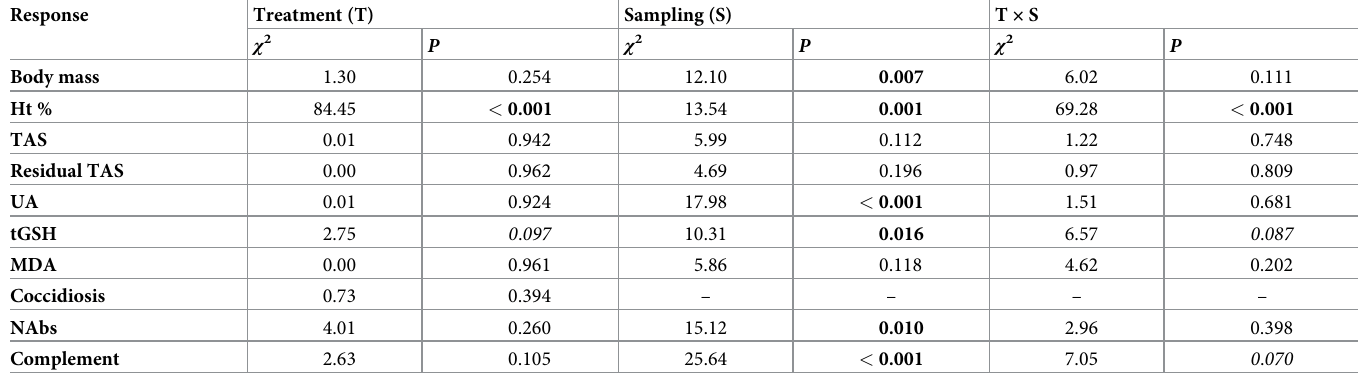
Table 1. Physiological effects of chronic CORT treatment. LMEs for body mass, hematocrit (Ht %), redox state markers (TAS—total antioxidant status, UA—uric acid, tGSH—total glutathione, MDA—malondialdehyde; for residual TAS, see Methods) and coccidian infestation, and GLMMs for innate immunity variables (natural antibod- ies [NAbs] by hemagglutination score and complement by hemolysis scores). Degrees of freedom are 1 for treatment and 3 for sampling and treatment × sampling throughout. Significant effects are marked in boldface and marginally significant effects (0.05 < P (cid:20) 0.10) in